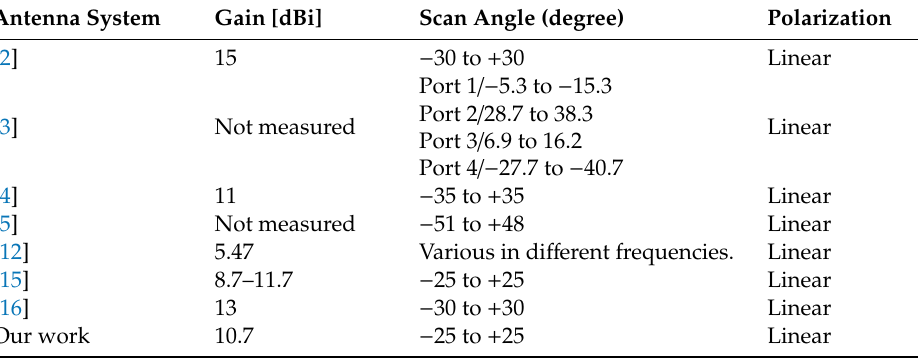
Table 4. Comparison of seven recent beam steering antenna systems with our design in terms of gain, scan range, and polarization.